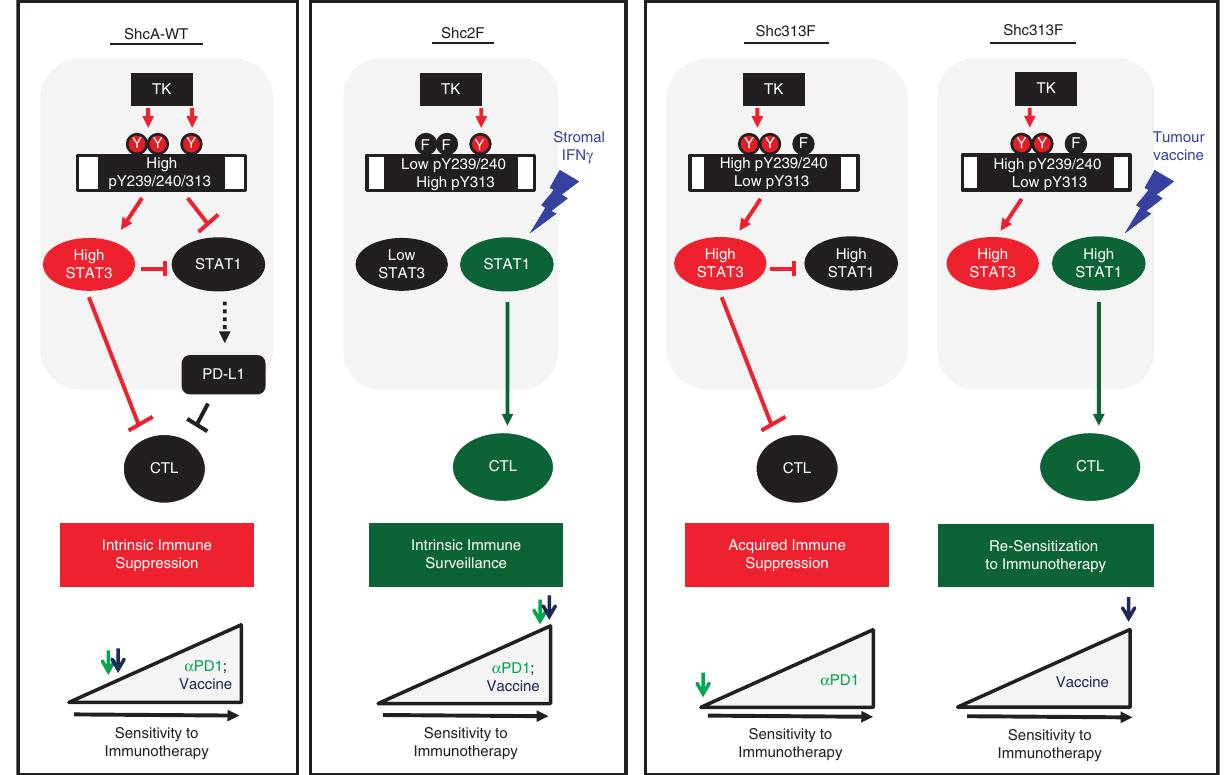
Figure 7 | Schematic representation outlining the role of how modulating the TK/ShcA axis impacts breast cancer immune suppression. Elevated STAT3 signalling promotes immune suppression in ShcA-WT breast tumours, which suppresses STAT1-driven anti-tumorigenic immune responses. Instead, STAT1 further contributes to immune evasion by increasing PD-L1 levels in mammary tumours. As such, these tumours display a modest sensitivity to PD1 immune checkpoint blockade or tumour vaccination strategies. In contrast, loss of the phospho-pY239/240 ShcA signalling (Shc2F) significantly and specifically impairs STAT3 activation in breast cancer cells. This relieves STAT3-driven immune suppression, leading to stromally induced activation of STAT1-mediated anti-tumorigenic responses in mammary tumours, which together promote immune surveillance and significant responsiveness to anti- PD1 therapies or tumour vaccines. Finally, specific loss of pY-313 ShcA signalling (313F) directly increases STAT1 signalling in breast cancer cells, leading to a compensatory hyperactivation of STAT3 signalling. Heightened STAT3 signalling in 313F mammary tumours sustains immune evasion, leading to increased resistance to PD1 checkpoint inhibitors. Paradoxically, however, increased STAT1 signalling in these tumours increases their sensitivity to tumour vaccination strategies, owing to the heightened increase in baseline STAT1